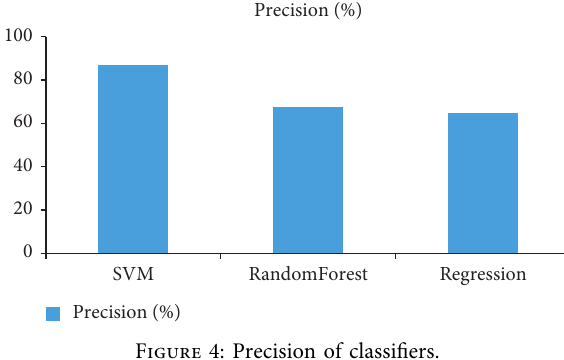
Figure 4: Precision of classifiers.